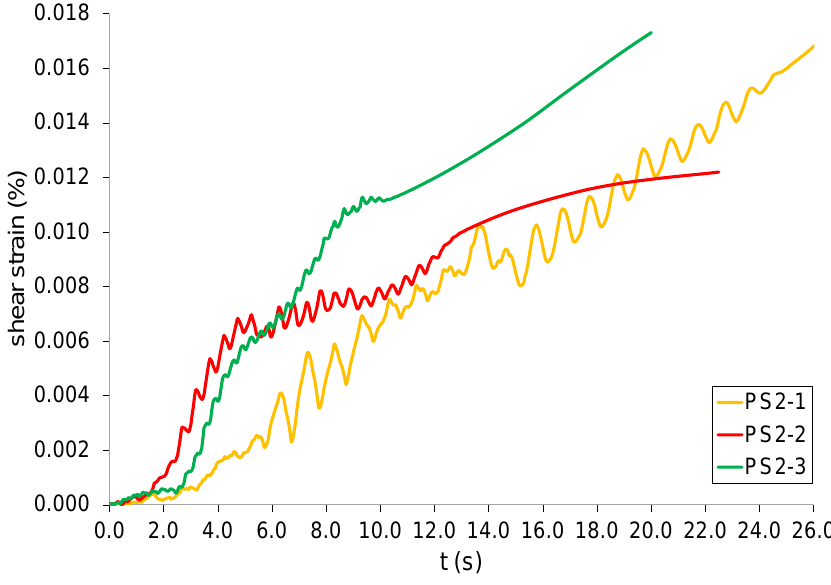
Figure 9. Shear strain time history (PS2-1; PS2-2; PS2-3) at −5 m depth.